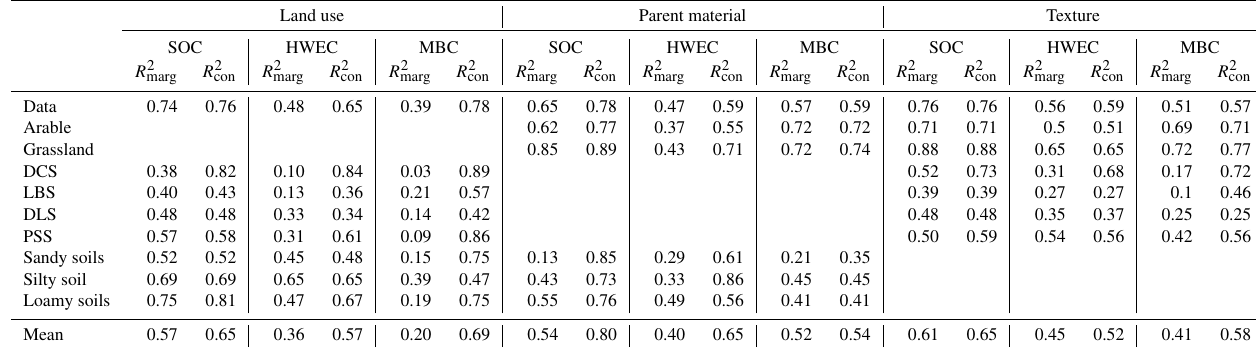
Table 4. R 2 marg and R 2 con of the models for SOC, HWEC, and MBC based on the results of mixed-effect models. Land use Parent material